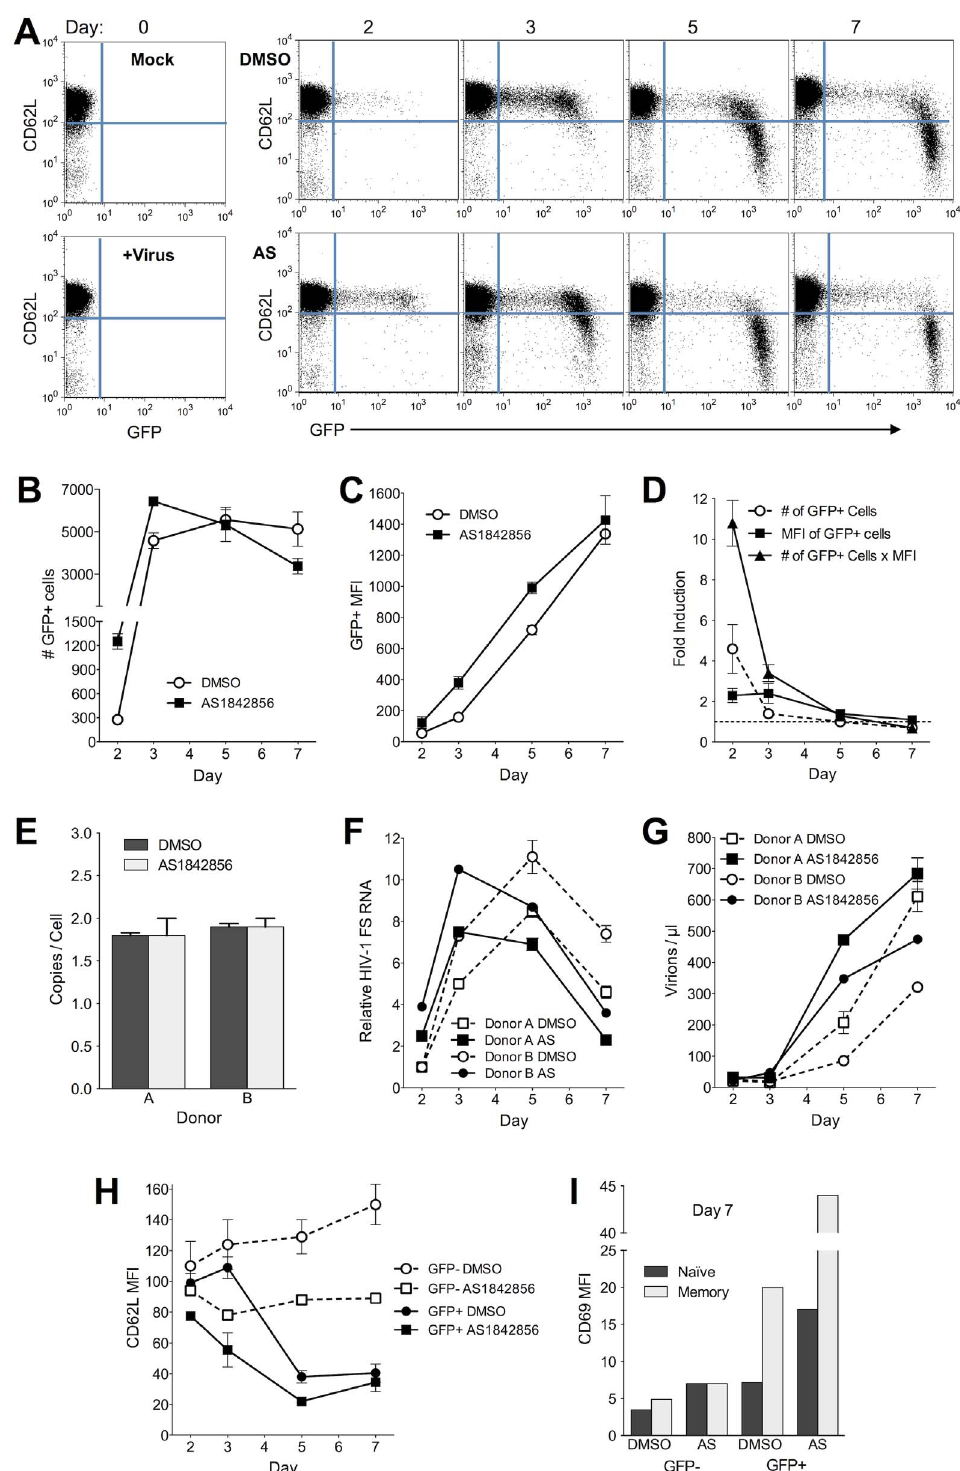
Figure 6. Foxo1 inhibitor AS1842856 accelerates HIV-1 expression. AS1842856 (AS) was applied to cells 1 day before and 1 day after infection with single round GFP reporter virus. CD45RO- naı¨ve T cells are shown. A. GFP and CD62L expression in infected naı¨ve CD4 + T cells on the indicated day after infection. Donor A is shown. B. The number of GFP + cells on the indicated day after infection. Data are average and SD of the two donors. C. Mean fluorescence intensity (MFI) of GFP in the GFP + cells. Data are average and SD of the two donors. D. Fold increase in the number and the MFI of GFP + cells, and total GFP fluorescence in the cells calculated as the product of the number of GFP + cells multiplied by their MFI. Data are average and SD of the two donors. E. Near-full length reverse transcripts on day 2 after infection for one representative cell donor. Data are averages and SD for replicate PCR reactions for each donor. F. HIV-1 fully spliced RNA presented relative to day 1 DMSO condition. Data are averages and SD for replicate PCR reactions for each donor. G. Virus production measured by genomic RNA in culture medium. Data are averages and SD for replicate